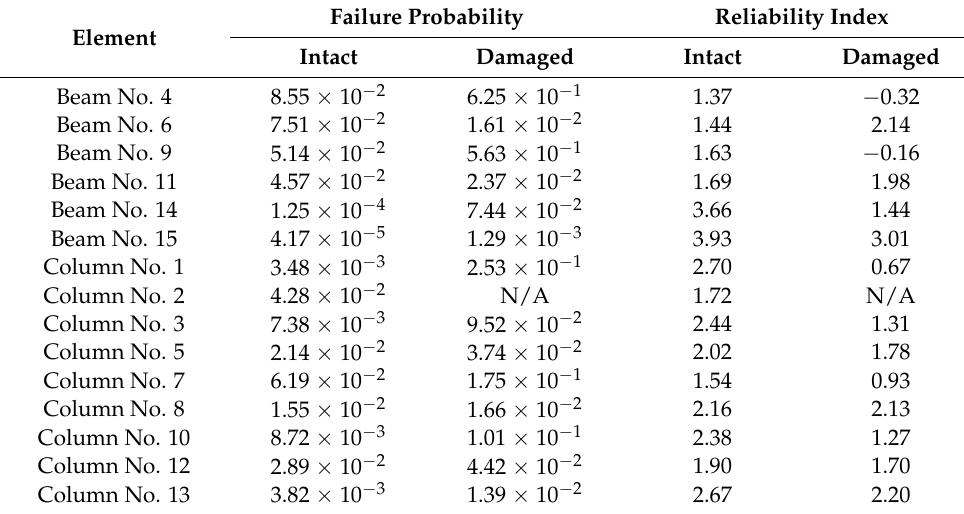
Table 2. Failure probability of structural elements.